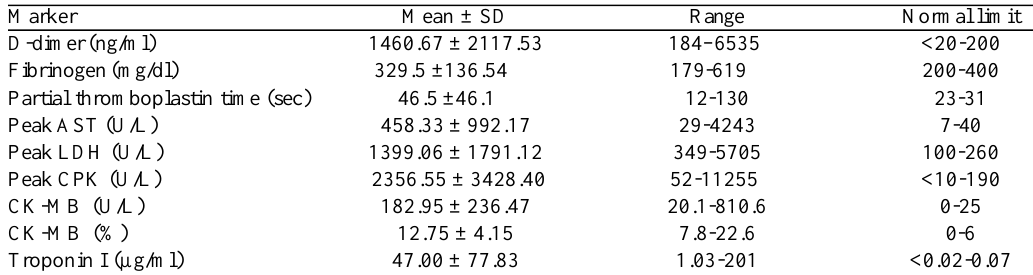
Table 1. The coagulation markers and serum enzymes after myocardial